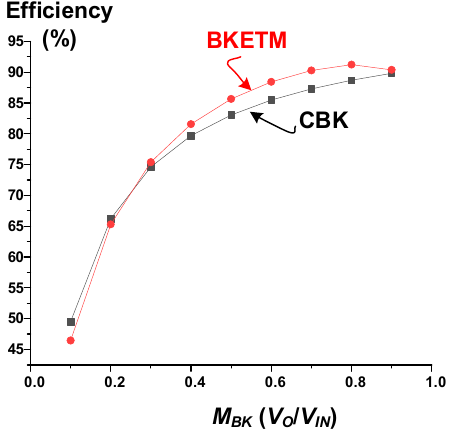
Figure 13. Simulated efficiency plot of a buck converter with ETM at different conversion ratios.